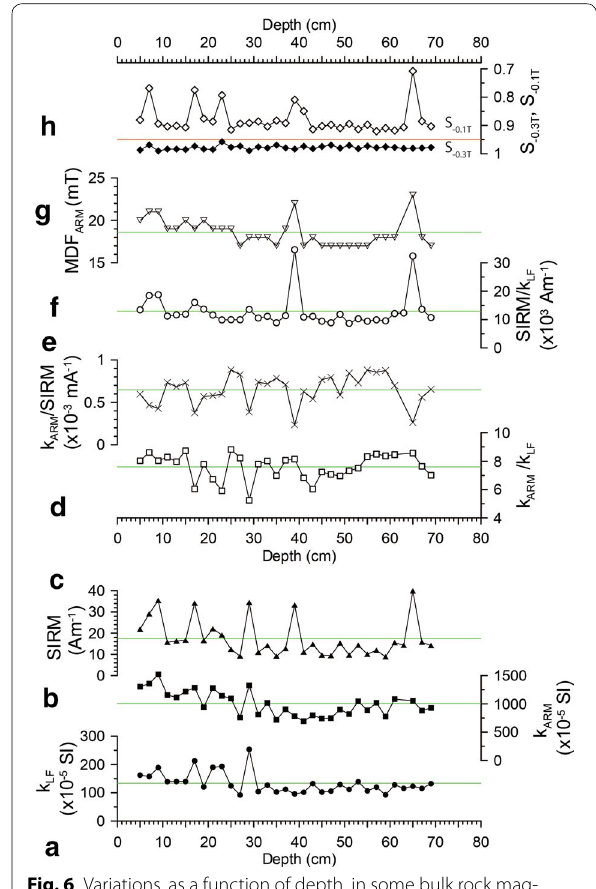
Fig. 6 Variations, as a function of depth, in some bulk rock mag‑ netic parameters from the GSDS1 profile, a k LF , b k ARM , c SIRM, d k ARM / k LF ratio, e k ARM /SIRM ratio, f SIRM/ k LF ratio, g MDF ARM , and h S ratios ( S and S ). Green bar for each of Fig. 5a–g denotes the − 0.1T − 0.3T individual average values. Values of these parameters are also listed